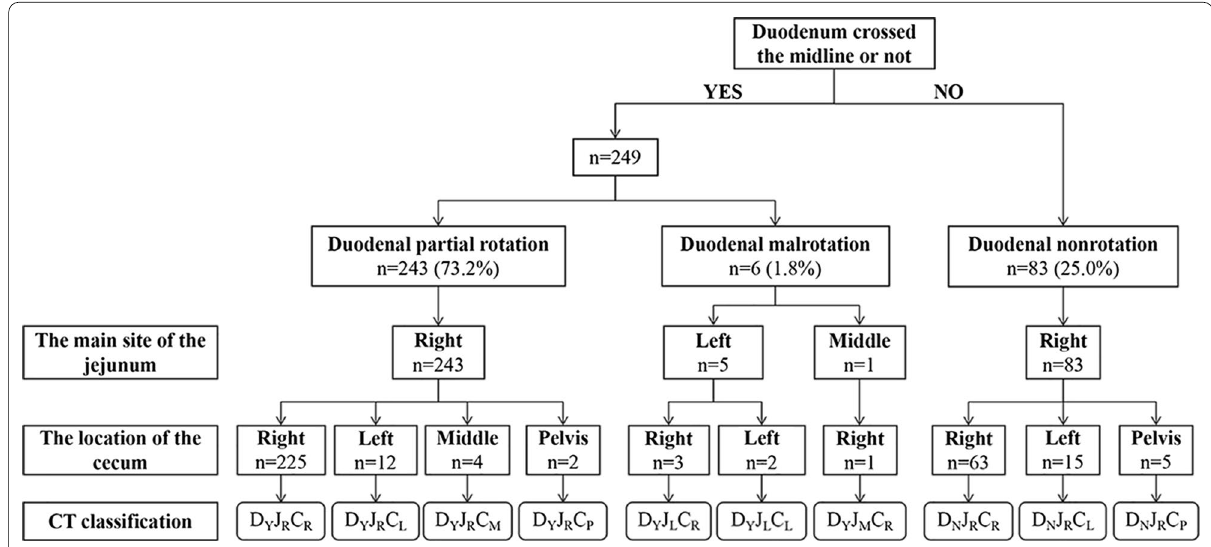
Fig. 1 Process and results of classification of abdominal CT